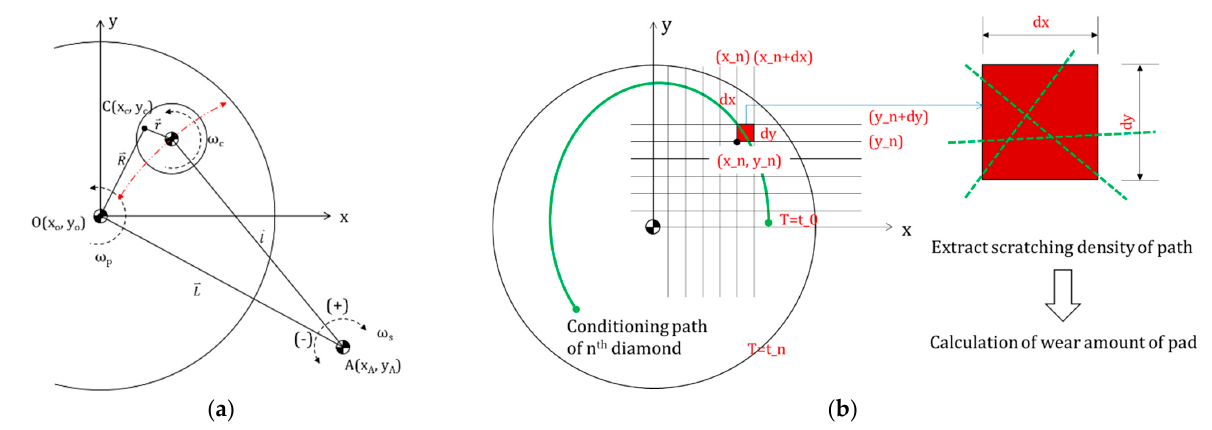
Figure 4. ( a ) Conceptual diagram of a motion model comprising a rotating disc, a pad, and a swing arm, ( b ) Schematic of the integration of the trajectory length within a specific area for predicting the wear amount.